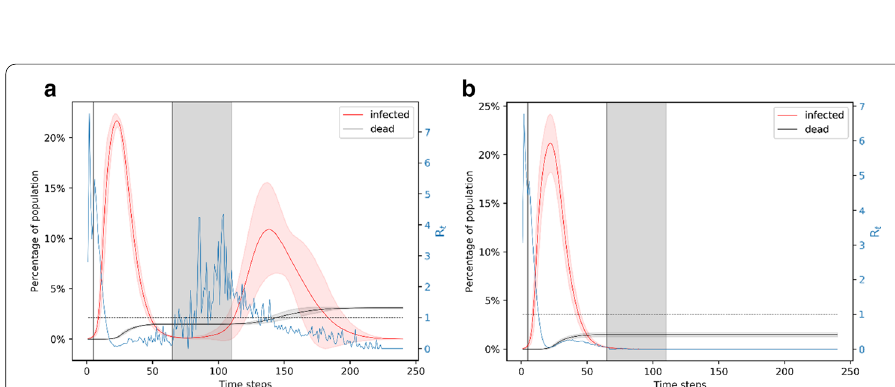
Fig. 10 Simulation of the case of phasing out of lockdown for 45 days. a Representation of the ~ 3% of simulation results that have a second wave of infection for the lockdown from day 5 to day 65 and complete normalcy resumes on day 110. b Representation of the ~ 59% of simulation results that have only one wave of infection for the lockdown from day 5 to day 65 and complete normalcy resumes on day 110. The 45-day phasing-out period after the lockdown is lifted makes a second wave of infection very